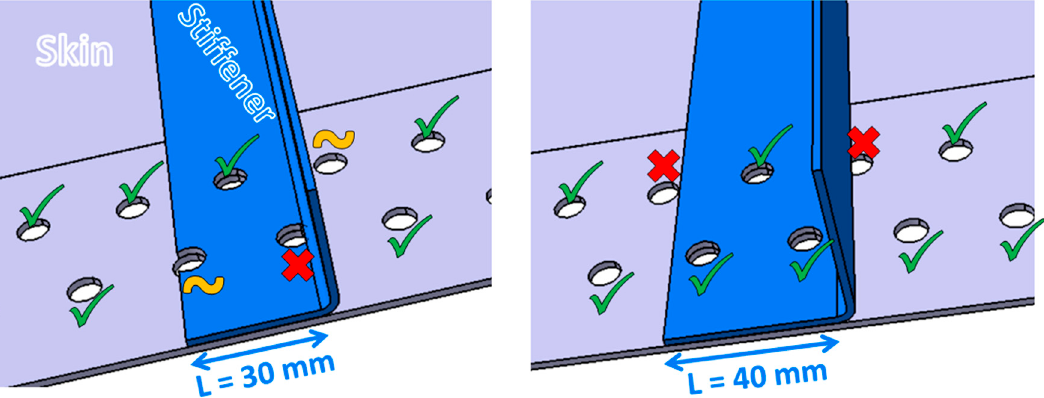
Figure 10. Bolting compliance of each hole of the stiffened specimen, depending on the stiffener flange width.